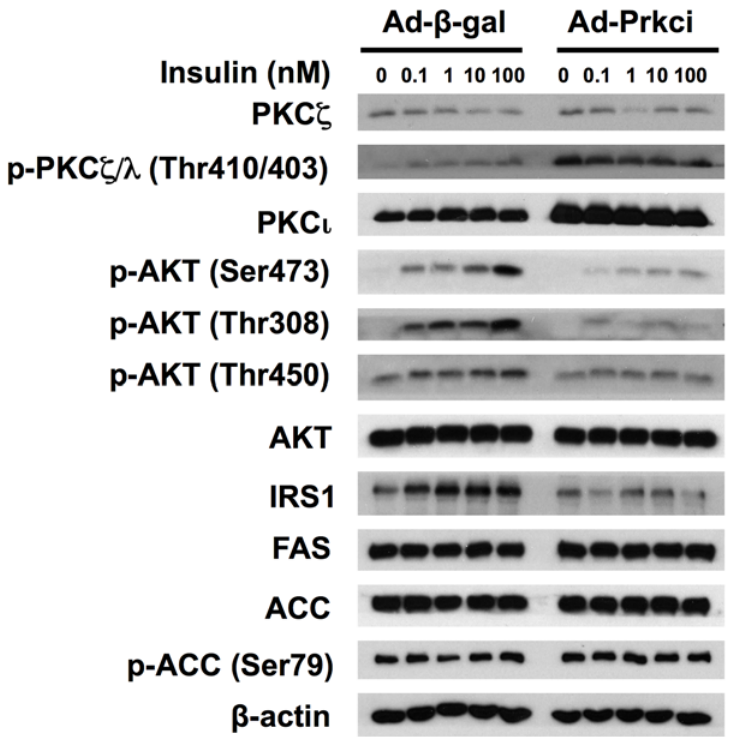
Fig 5. Overexpression of PKC ι / λ attenuated the activation of insulin signaling cascade in primary hepatocytes of ZL rats. Primary hepatocytes of ZL rats fed chow for 8 weeks were isolated and seeded onto dishes as described in the Materials and Methods. Purified Ad- β -gal and Ad-Prkci were added in ZL primary rat hepatocytes during the overnight pretreatment period to allow the overexpression of β -GAL and PKC ι / λ , respectively. Cells were then incubated in fresh medium A with increasing concentrations of insulin (0 nM to 100 nM) for 15 min. The whole cell lysates were subjected to immunoblot analysis with antibodies against indicated proteins. The figure shows the representative result of three parallel experiments obtained from three sets of